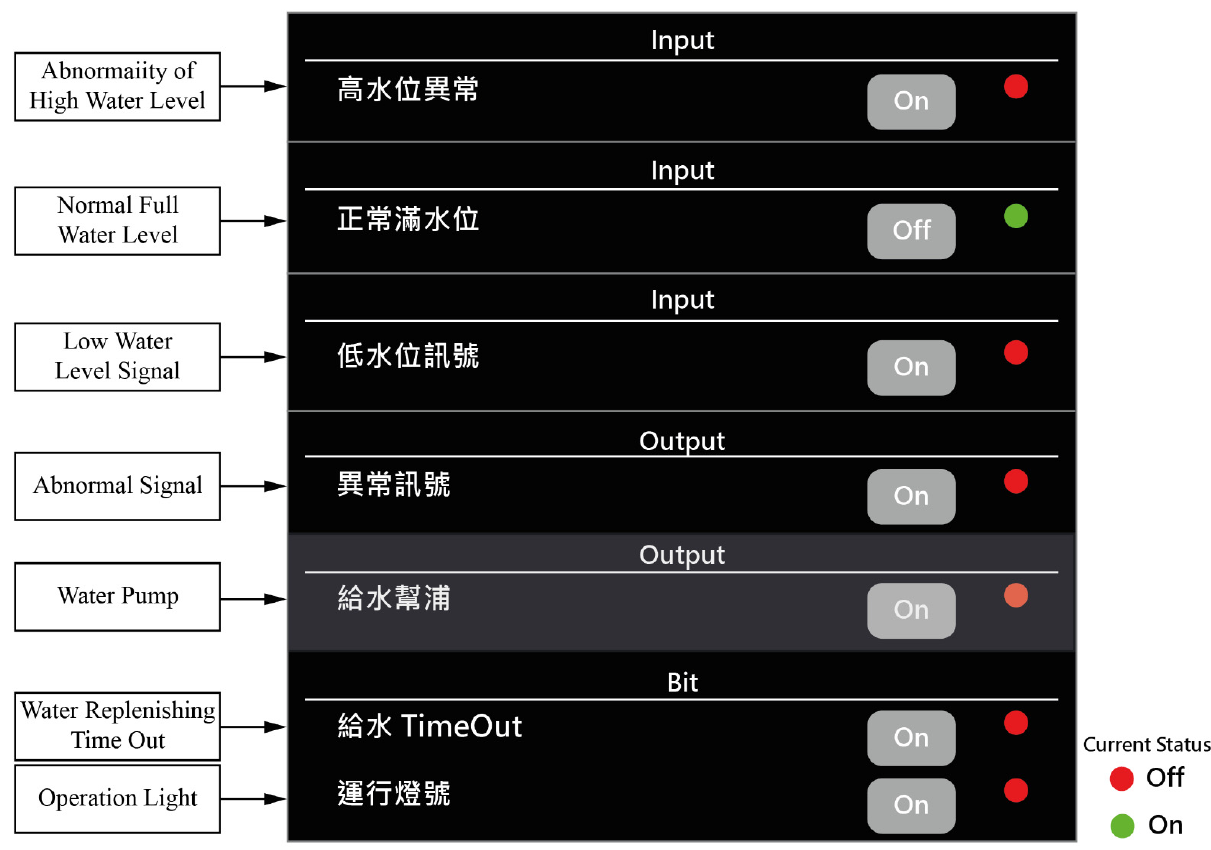
Figure 10. Mobile device (cell phone) screen display—part 1.